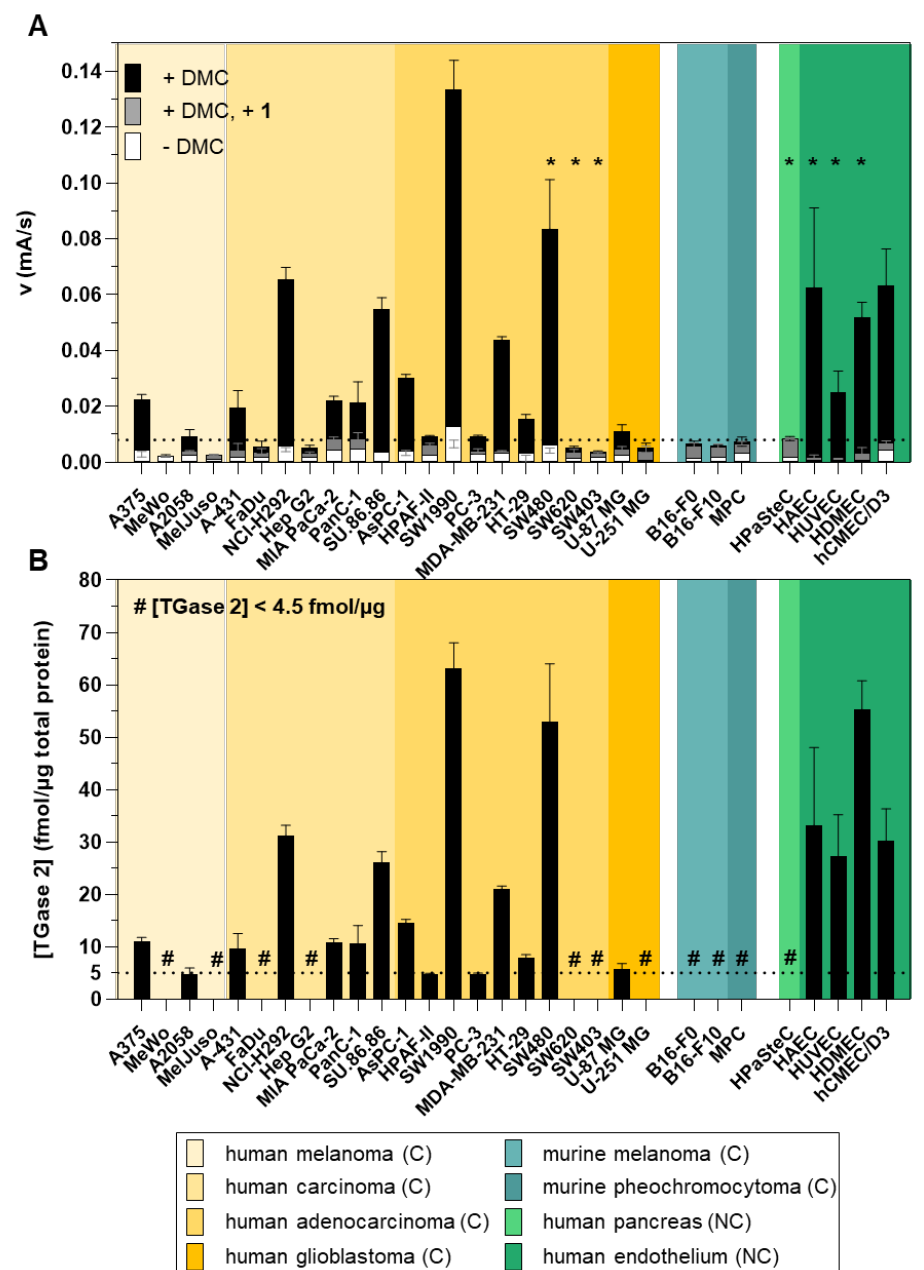
Figure 4. TGase activity determined by FA-based assay in lysates of different human and mouse cancer cell lines (C) and human noncancer cell lines (NC). ( A ) Summary of FA rates (mean values ± SEM of 2 – 5 separate experiments, each performed in duplicate) for the reaction of DMC (30 µM) with R-I-Cad (0.81 µM) in the presence of different cell lysates (2 g/L). For some cell lines (marked with *), lysate concentrations of 0.5 g/L (HDMEC and HUVEC), 1 g/L (HAEC and HPaSteC) or 1.5 g/L (SW480, SW620, and SW403) were used. The dotted line indicates an FA rate value of 0.008 mA/s, which is the detection limit to reliably detect an increase in the FA signal over time. ( B ) Summary of calculated hTGase 2 concentrations (mean values in fmol/ µ g total protein ± SEM) in the different cell lines based on the FA rate values “+DMC” (black bars in ( A ). For cell lines marked with #, the FA rate lies below the detection limit and thus only an upper limit for the respective TGase 2 concentration can be given. For ( A , B ), cell lines were sorted by tumor type and indicated by different colors as shown in the legend. Conditions: pH 8.0, 30 ◦ C, 2.7 mM CaCl 2 , 5% DMSO, 500 µ M DTT, 30 µ M